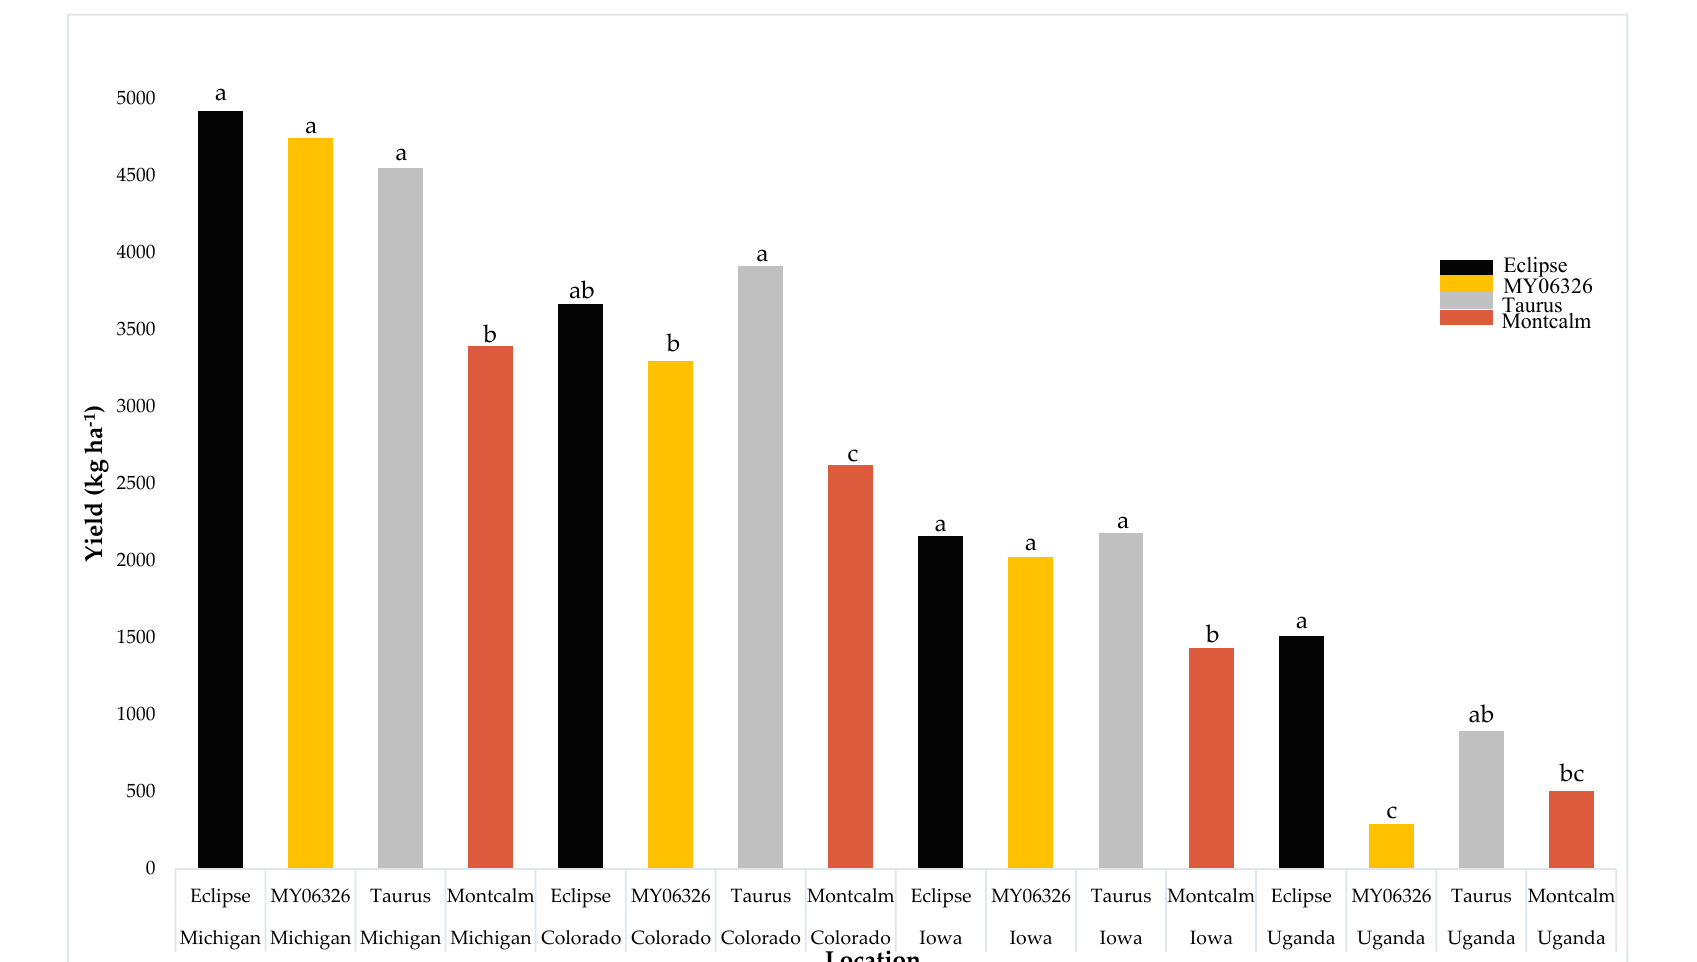
Figure 1. Common bean yield (kg/ha) of four genotypes (Eclipse, MY06326, Taurus, Montcalm) grown in Michigan, Colorado, Iowa and Uganda. Means within a location with different letters differ at P = 0.05 by Tukey-Kramer test. Location × variety interaction SE = 771.